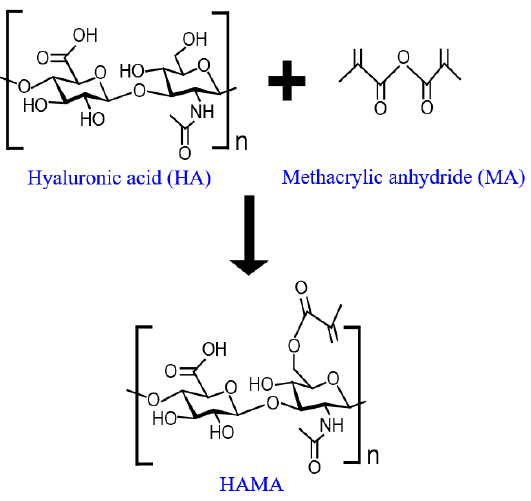
Figure 2. Schematic representation of the synthetic route of HAMA hydrogel.